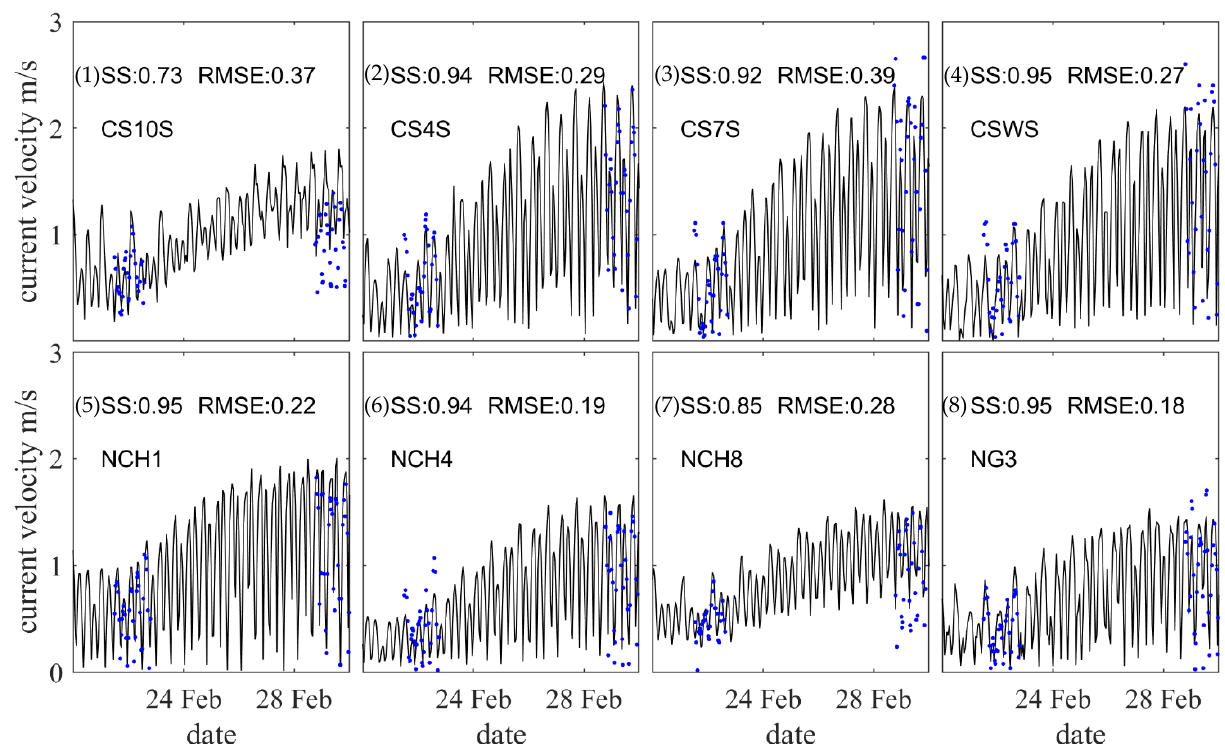
Figure 7. Model validation results for current velocity. (1)–(8), measured (blue dots) and simulated (black line) results at CS10S, CS4S, CS7S, CSWS, NCH1, NCH4, NCH8, and NG3, respectively.